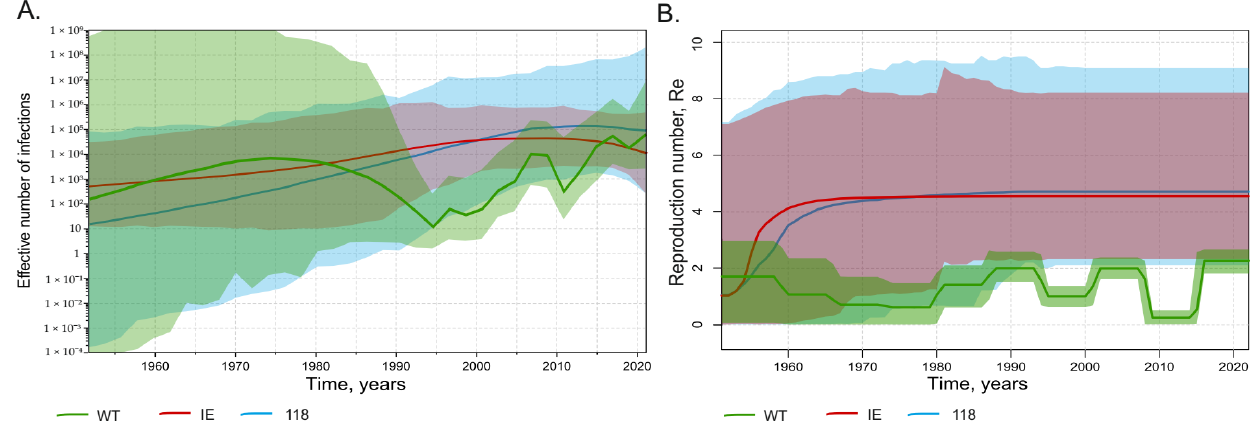
Figure 5. SkyGrid reconstruction ( A ) showing the relationship between the effective number of infections ( y axis) and chronological time expressed in years ( x axis), and Birth–Death Skyline reconstruction ( B ) showing the relationship between the reproduction number of infections ( y axis) and chronological time expressed in years ( x axis). The curves indicate the mean, and the 95% HPD interval is shown by the shaded area. Graphs for wild-type HBV sequences are shown in green, for immune-escape HBsAg variants except T118A/V in red, and for T118A/V variants in light blue.